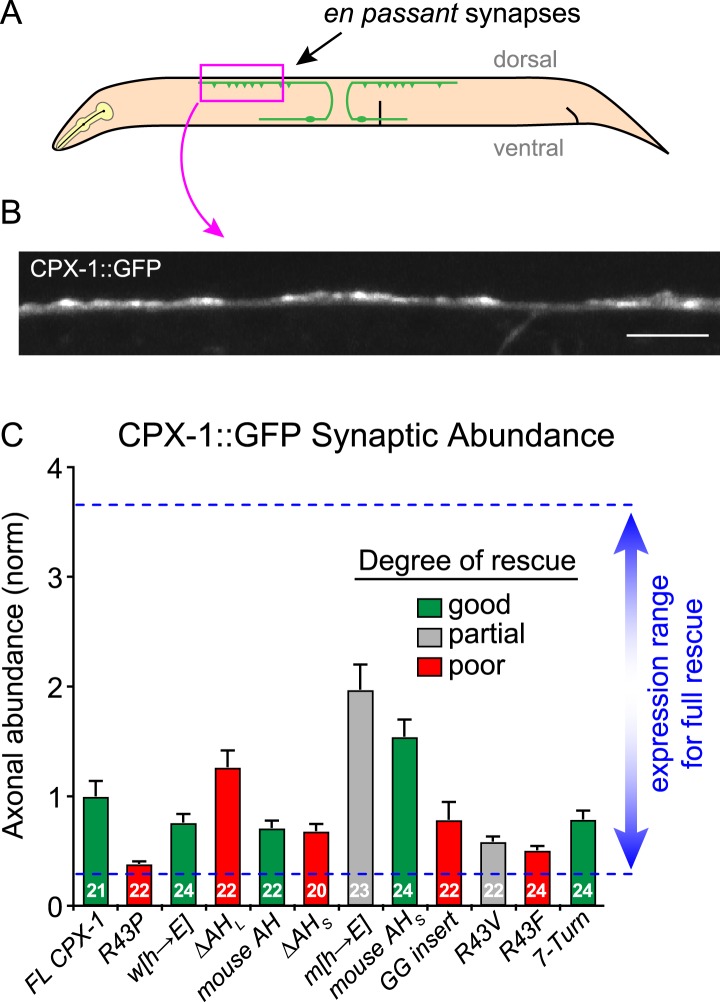
Axonal protein abundance for CPX-1 transgenes.(A) Schematic of a worm depicting the region imaged for axonal expression (pink box). All rescuing transgenes were quantified by imaging the C-terminal GFP tag in single axons of immobilized intact animals. (B) Representative confocal image of CPX-1::GFP fluorescence in a dorsal cord axon of an intact animal. Scale bar is 5 microns. (C) Average axonal fluorescence values for transgenic animals used in this study. Fluorescence was background-subtracted and averaged for at least 20 animals for each strain (number indicated in the bars). All data were normalized to a full-length wild-type CPX-1::GFP rescue strain and plotted as mean ± SEM. The blue dotted lines represent the range of expression found to rescue aldicarb sensitivity based on prior studies using a previously described axonal expression quantification protocol (Wragg et al., 2013).